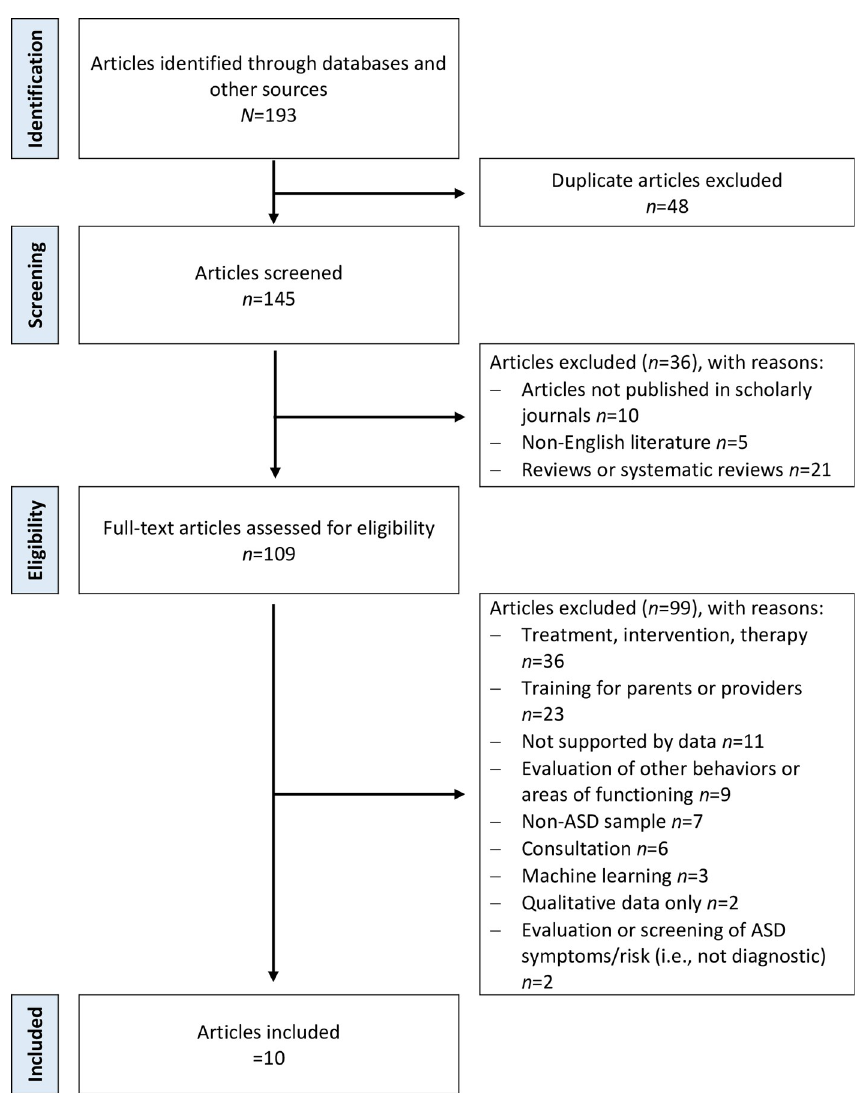
Fig 1. PRISMA flow diagram for selection of